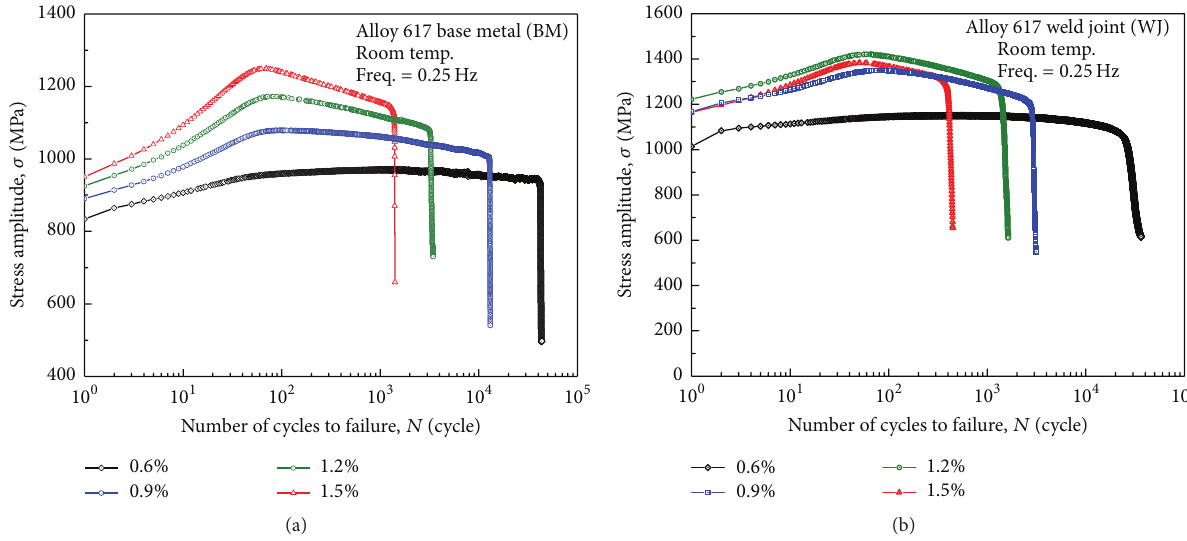
Figure 5: The stress amplitude as a function of number of cycles for (a) Alloy 617 BM and (b) Alloy 617 WJ.